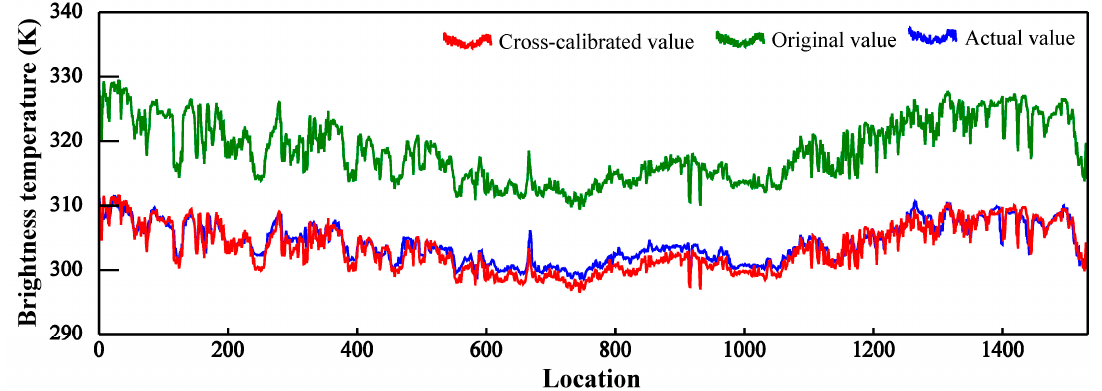
Figure 7. Comparison of the BT of MERSI-2 Band 24 before and after cross-calibration.